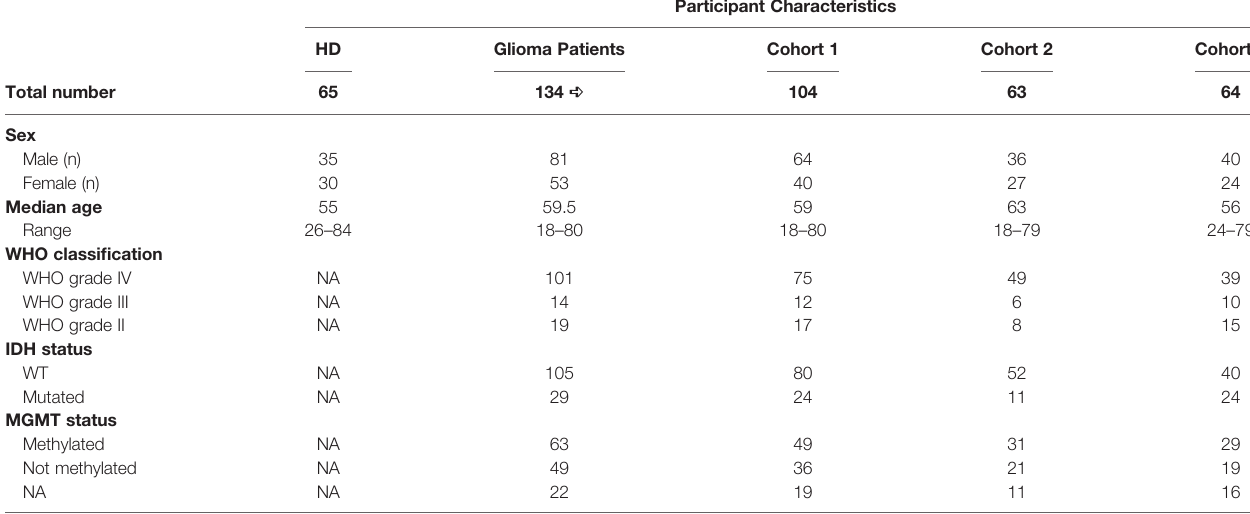
TABLE 1 | Participant